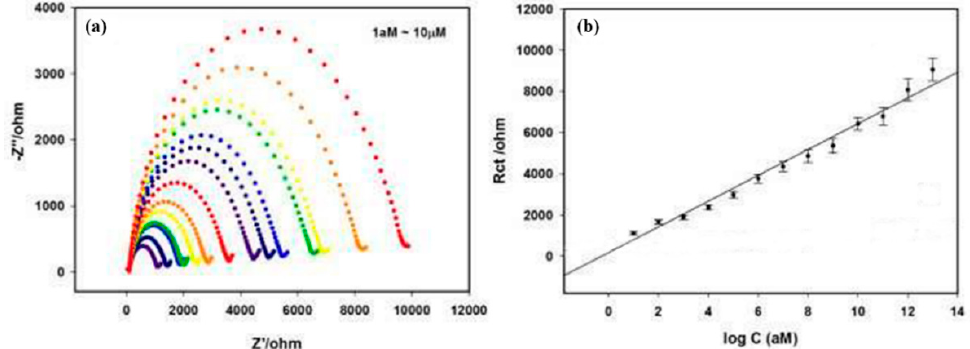
Figure 20. ( a ) EIS response of the MIP sensor towards 17- β -estradiol in the concentration of 1aM to 10µM. ( b ) Calibration curve of the R ct values versus the logarithm concentration of 17- β -estradiol. Modified with permission from [223]. Copyright 2018 Elsevier.